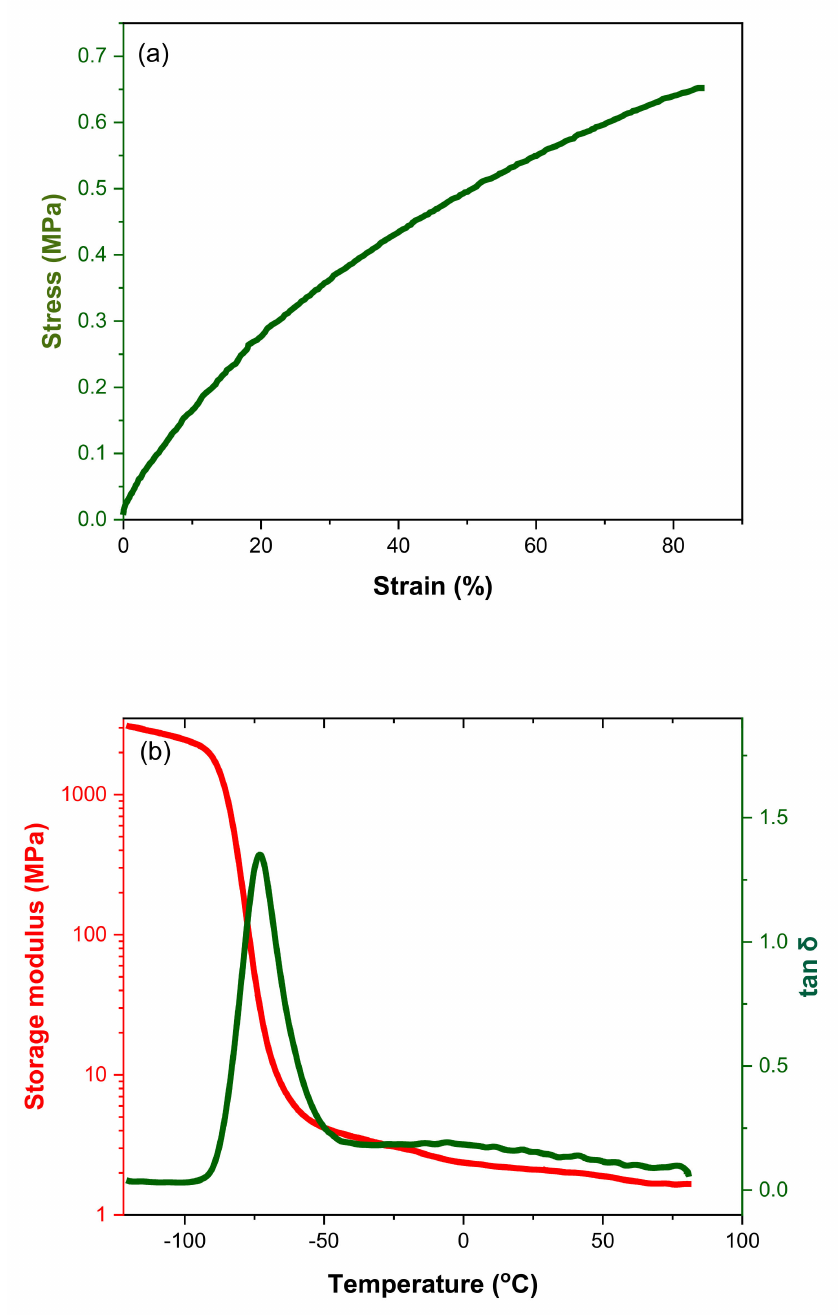
Figure 5. ( a ) Stress-strain behavior of the LBR cured at 75 ◦ . ( b ) Storage modulus and mechanical loss